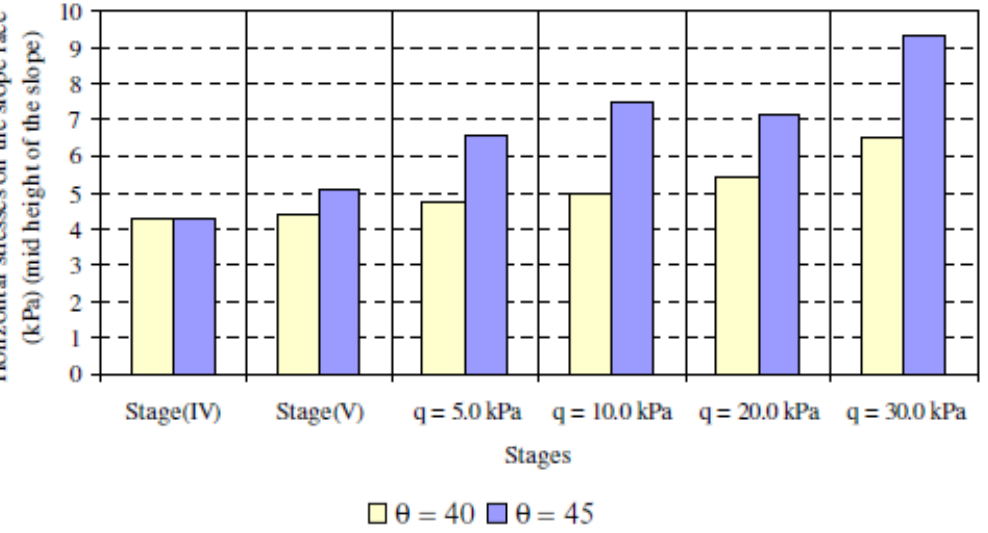
Figure 15. Influence of slope inclination on the slope face horizontal stresses at mid-height of slope.